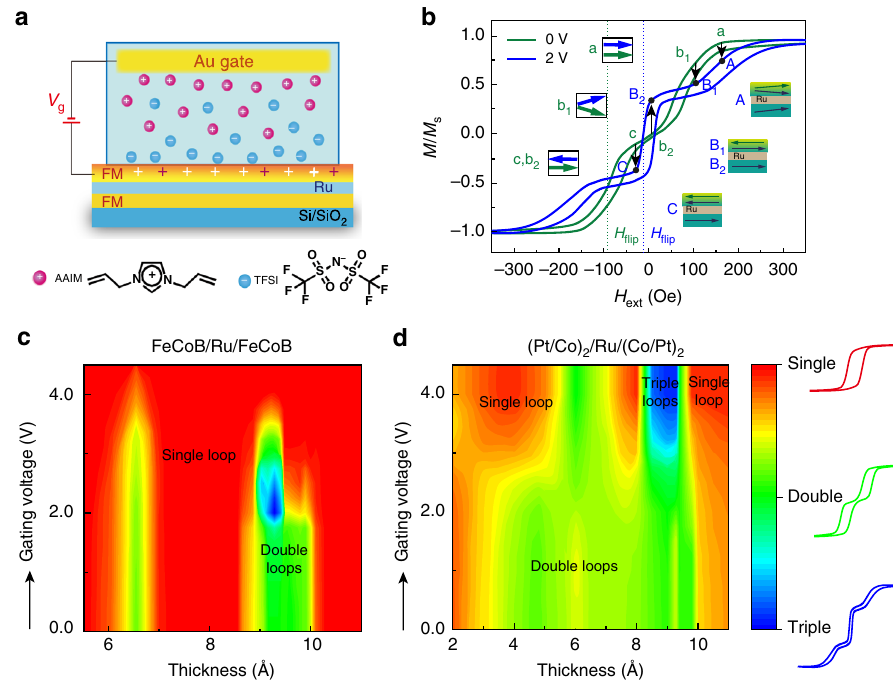
Fig. 4 Discussion and generalization for voltage-controlled RKKY interaction. a Schematic of IL gating magnetism modi fi cation process for FM/Ru/FM SAF multilayers. b Hysteresis loops of magnetic moment switching during the transition of double-loop and triple-loop pattern. The IL gating effect for FeCoB (1.5 nm)/Ru (0.92 nm)/FeCoB (1.5 nm) SAF structure is chosen as a representative diagram. c In-plane and d out-of-plane RKKY interaction phase diagram, which summarize the variation of hysteresis loops with Ru thickness and gating